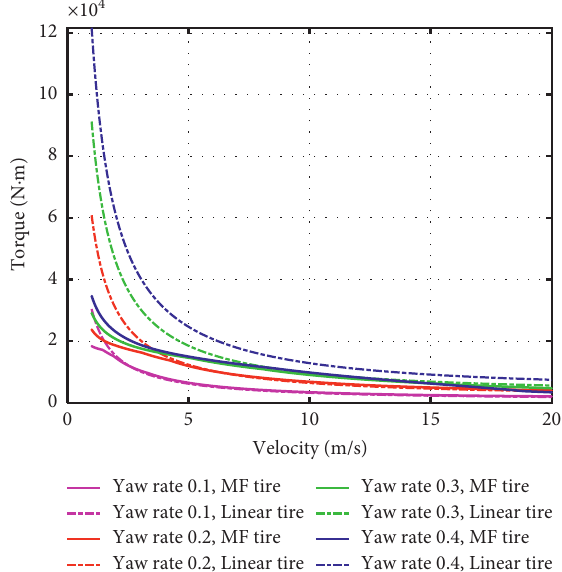
Figure 5: Comparison of need torque during the steering process.